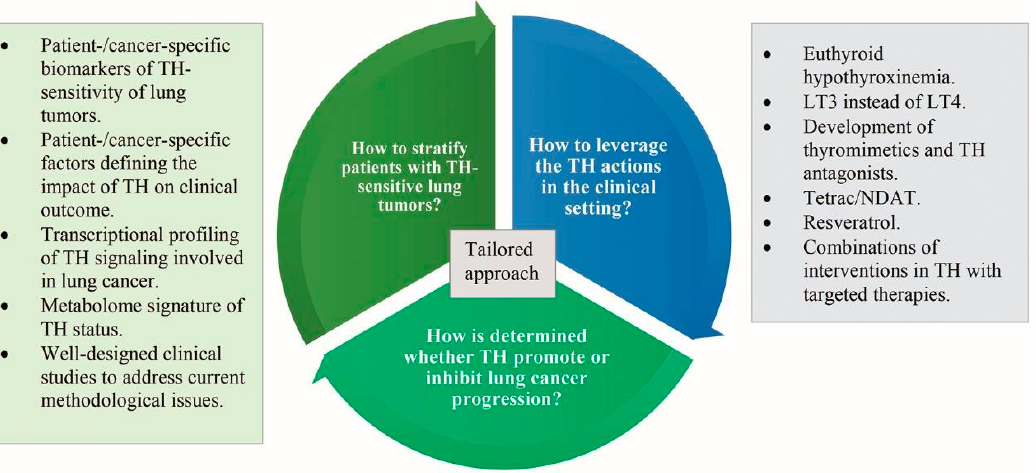
Figure 3. The pending queries and the main corresponding research priorities relevant to a tailored approach to the TH–lung cancer association. The tertiles of the pie depict the three pending queries, and the corresponding rectangles depict the corresponding research priorities. To stratify patients with TH-sensitive lung tumors and to clarify the dual role of TH in lung cancer, the research priorities are similar and include identification of patient-/cancer-specific biomarkers/risk factors, transcriptional profiling of TH signaling cross-talking with oncogenic signaling, exploration of the metabolome signature of TH status to assess precisely the intracellular and intratissue TH status, and well-designed clinical studies. To leverage the TH-lung cancer association in the clinical setting, the research priorities include exploration of interventions in TH as anticancer strategies, such as euthyroid hypothyroxinemia or administration of LT3 instead of LT4 to treat hypothyroidism; de- velopment of thyromimetics and TH antagonists; exploration of the anticancer potential of tetrac, NDAT, and resveratrol; and establishment of combinations of interventions in TH with targeted therapies. Abbreviations: LT3, liothyronine; LT4, levothyroxine; NDAT, nano-diamino-tetrac; TH, thyroid